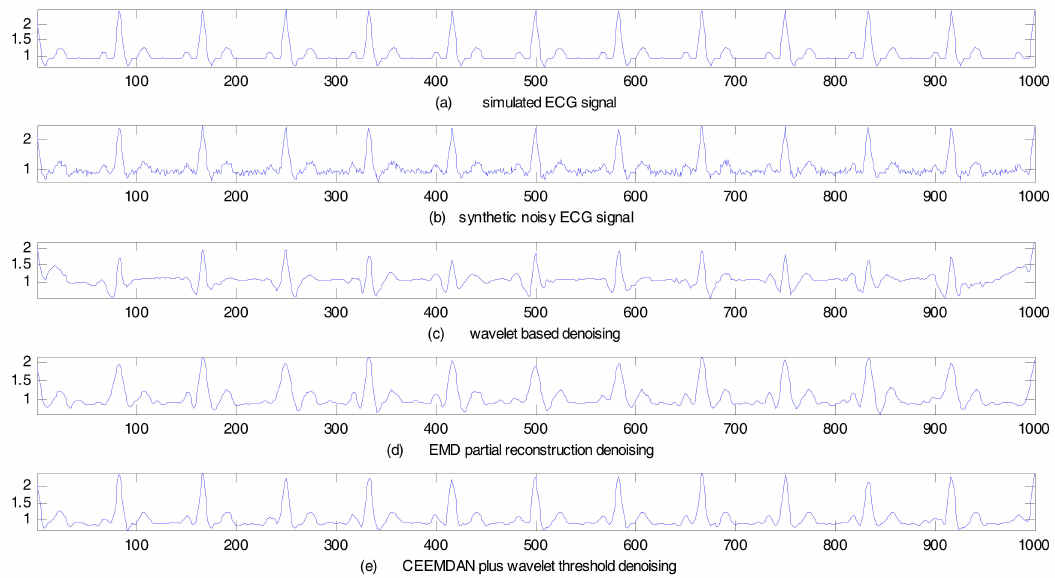
Figure 5. Synthetic noisy ECG (simulated ECG) signal de-noising